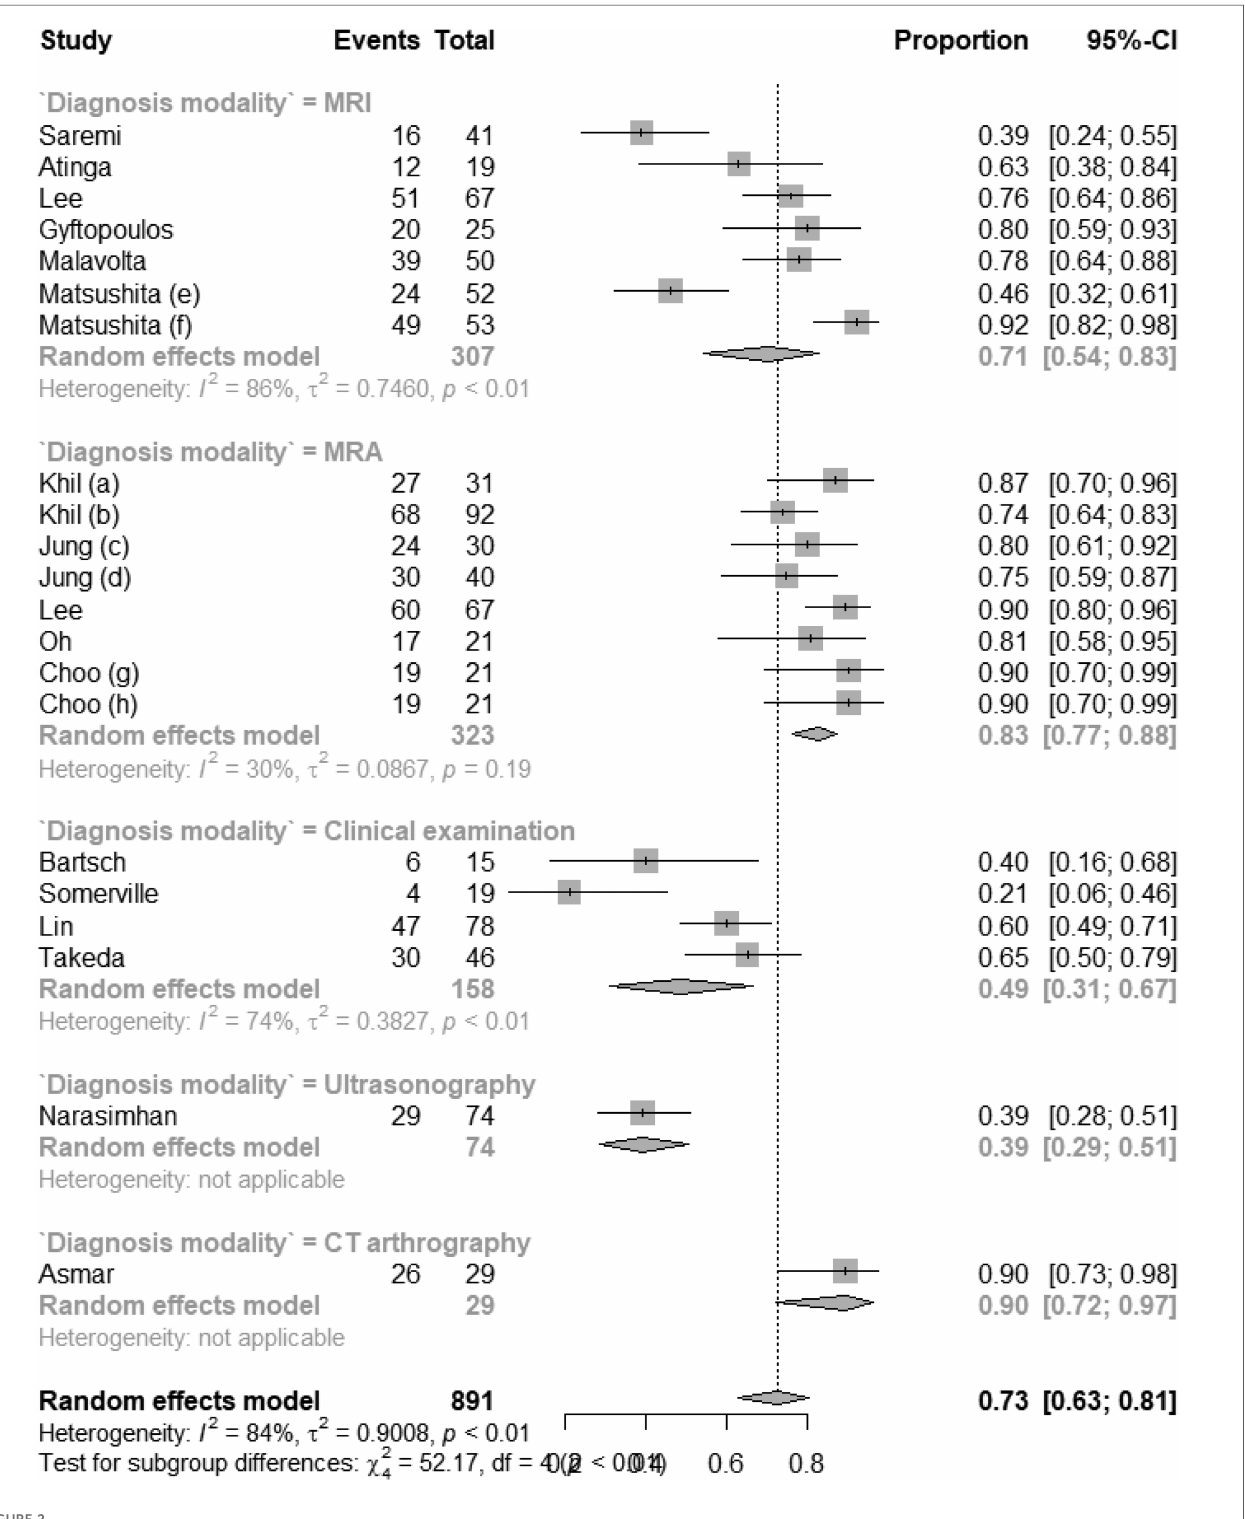
FIGURE 2 Forest plot of sensitivity of different diagnostic